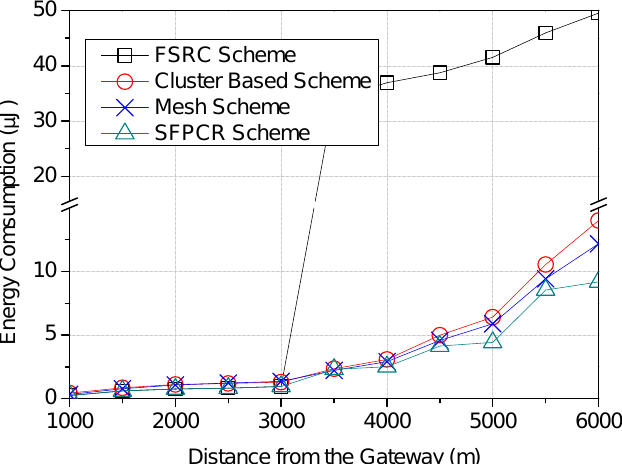
Figure 10. Energy consumption as a function of LoRa devices’ distance from the GW (m) with a comparison between the proposed SFPCR scheme and other